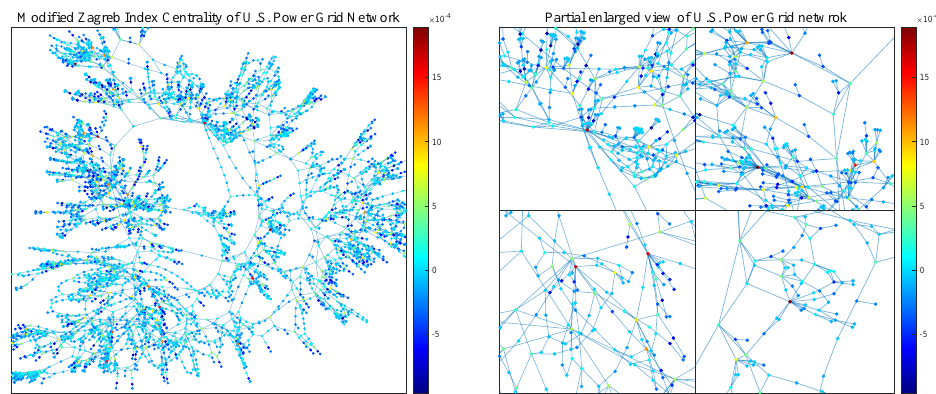
Figure 13. It shows how each vertex affects the robustness of the U.S. Power Grid network, where these vertices are measured using Modified Zagreb Index Centrality and then